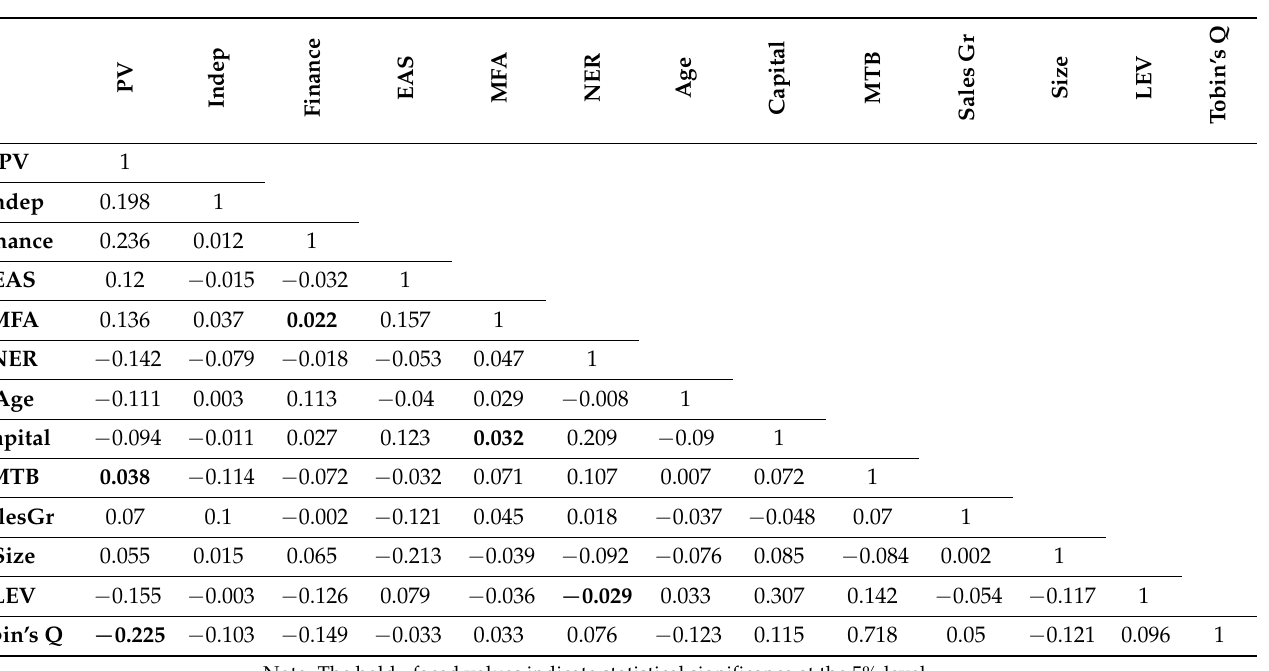
Table 2. Correlation coefficients of high-level political connections.